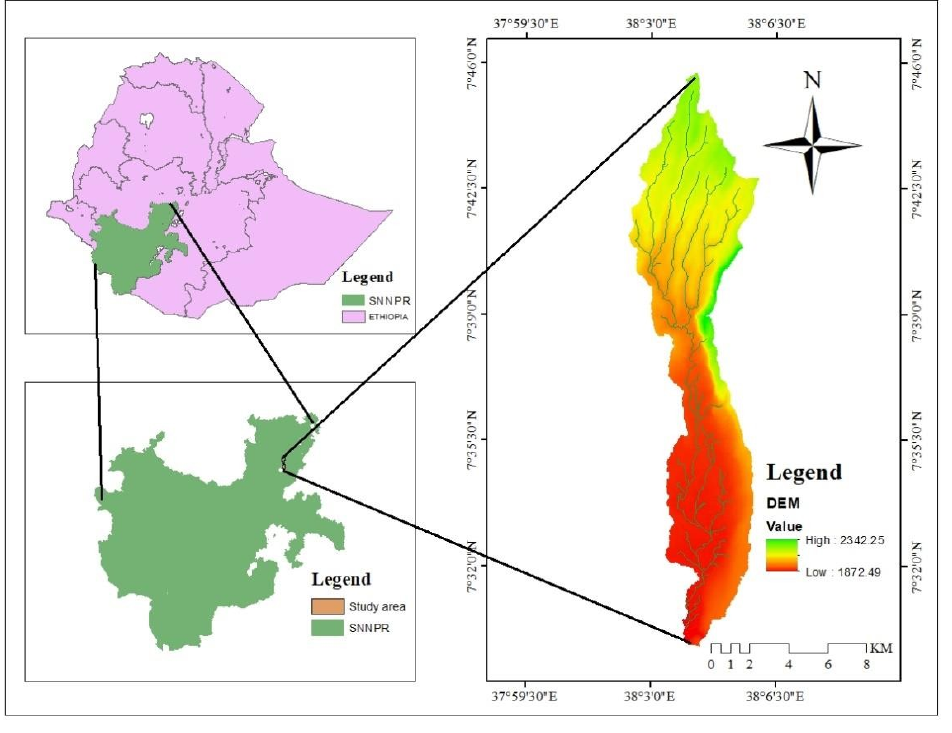
Figure 1. Matenchose watershed map.